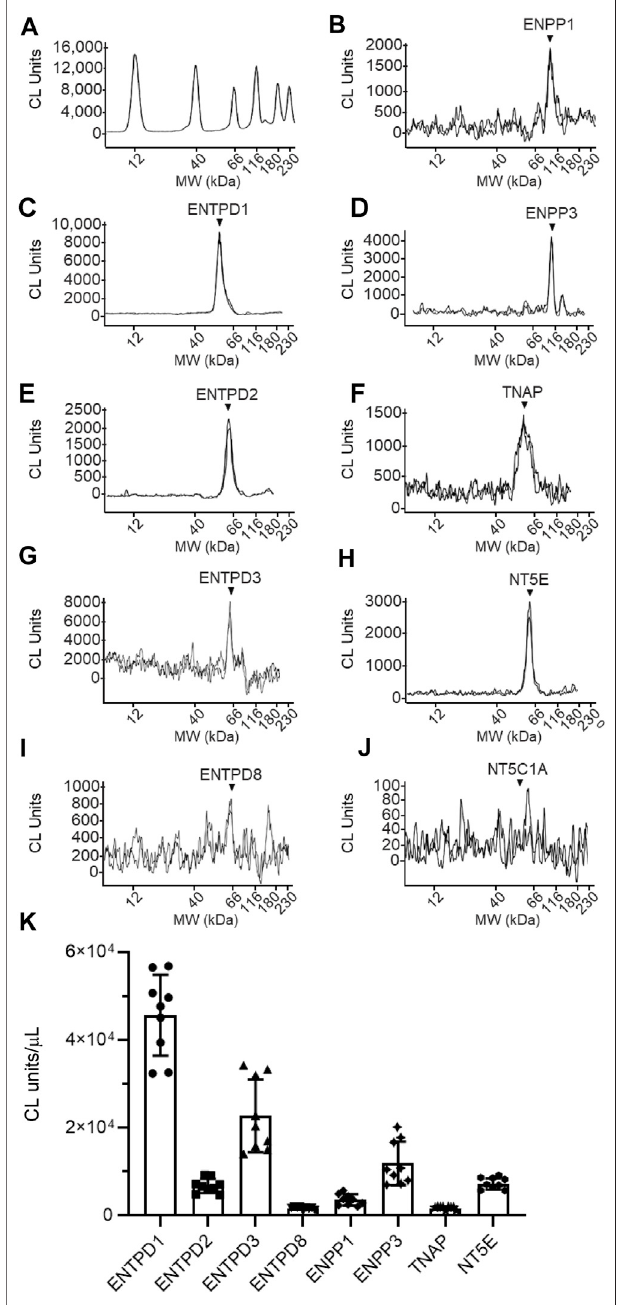
FIGURE 10 | Protein expression levels in urothelium homogenates prepared from detrusor-free bladder preparations. Representative immunoelectropherograms (duplicates) of nucleotidases detected in urothelium using ProteinSimple Wes (A – J) . Each antibody was diluted 100-foldandeachwellcontained6 µgofurotheliumhomogenatesample.The antibodies used are described in Figure 9 and in main text Antibodies. (K) Scatter plots of AUC of chemiluminescence (CL) signals normalized per µg loaded urothelium sample. Each symbol represents a single loading from 5 urothelium samples, loaded in triplicates. Statistical signi fi cance is described in main text Results.